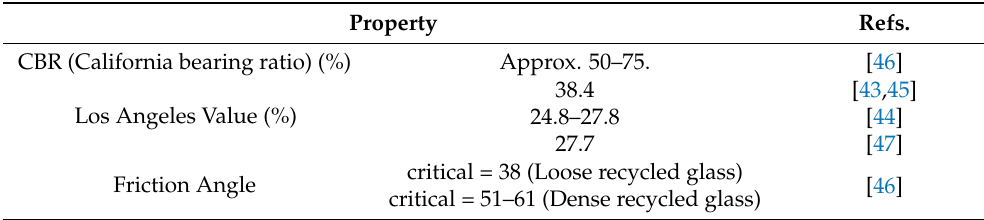
Table 4. Mechanical properties of crushed